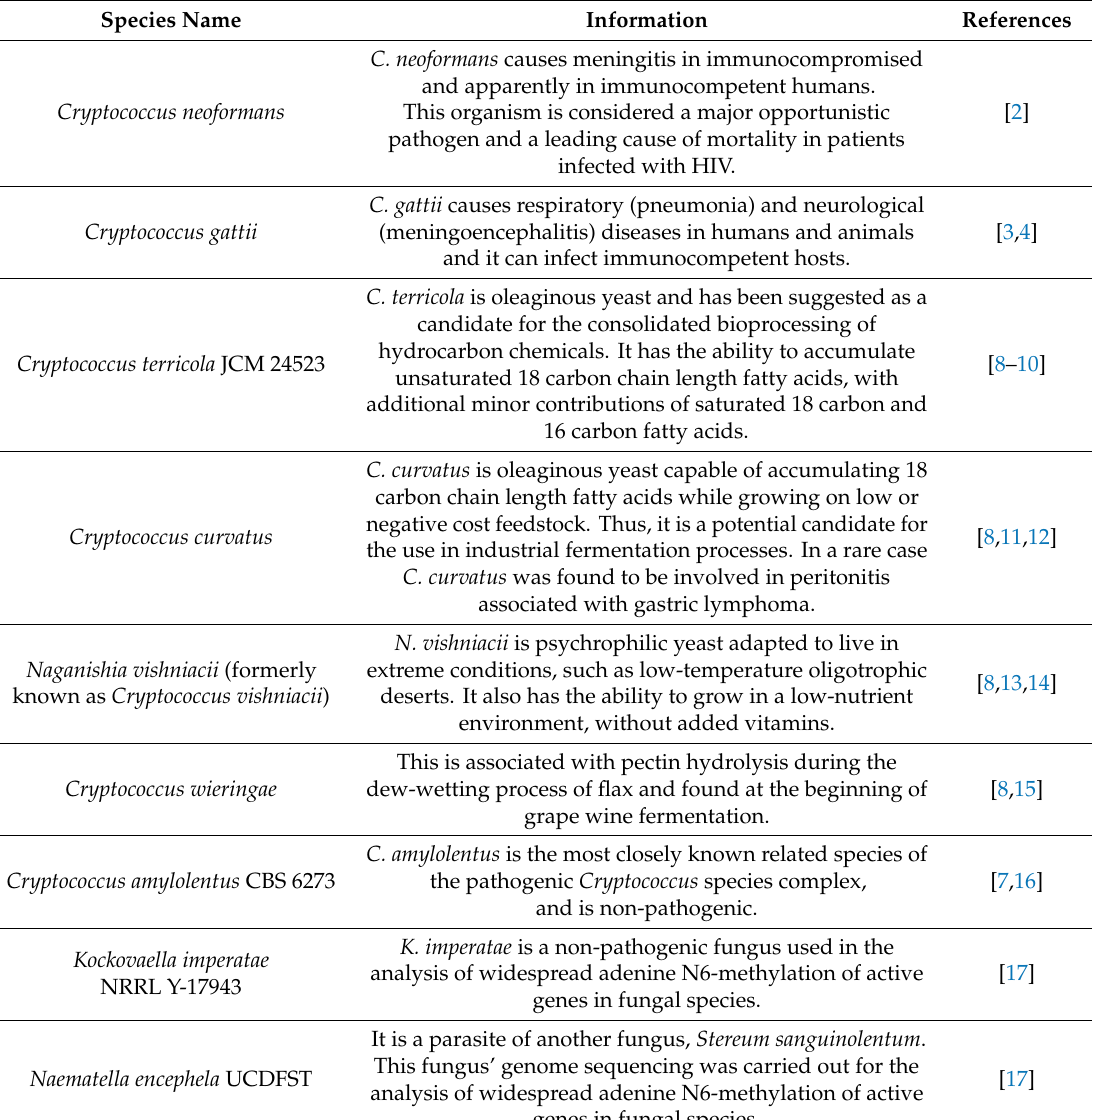
Table 1. Some species of Tremellomycetes and their well-known